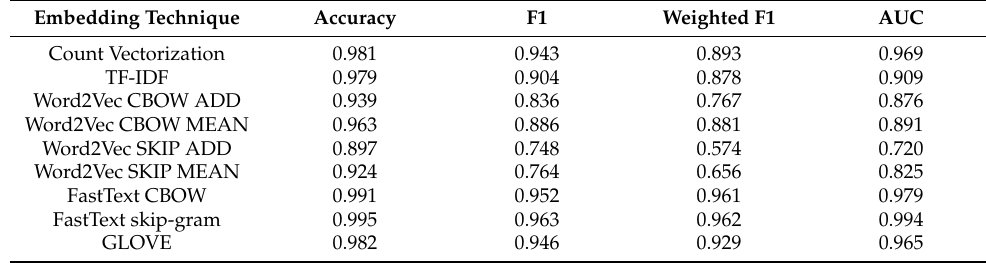
Table A1. Performance metrics for logistic